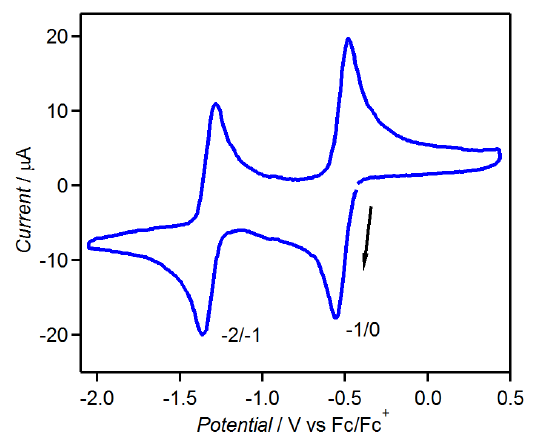
Figure 14. CV of 1 mM tdapO permission from [47]. Copyright 2011 American Chemical Society.